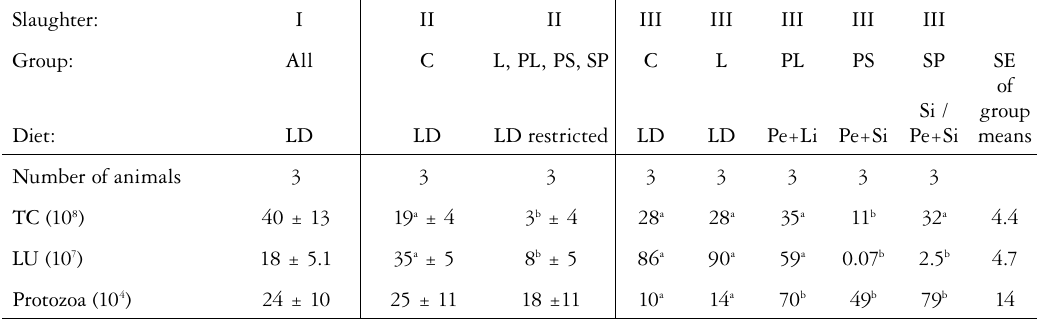
Table 4. Counts of total culturable (TC) bacteria, lichen-utilizing (LU) bacteria and protozoa per g of rumen content in female reindeer calves fed various diets (Group C, controls, fed a lichen based diet ad libitum , Group L, PL, PS and SP, first fed a restricted amount of the lichen-based diet, half the ad libitum amount, followed by one day without feed and then fed different diets ad libitum ), and slaughtered on three occasions (Slaughter I, at the start of the experiment, Slaughter II after nine days restriction period and Slaughter III, at the end of the experiment) (least square means ± standard errors). Means within row and slaughter occasion with different superscripts are significantly different. Significant changes in controls with time are specified in the text. LD = lichen-based diet, , Pe = pellets, Li = lichens, Si = silage.